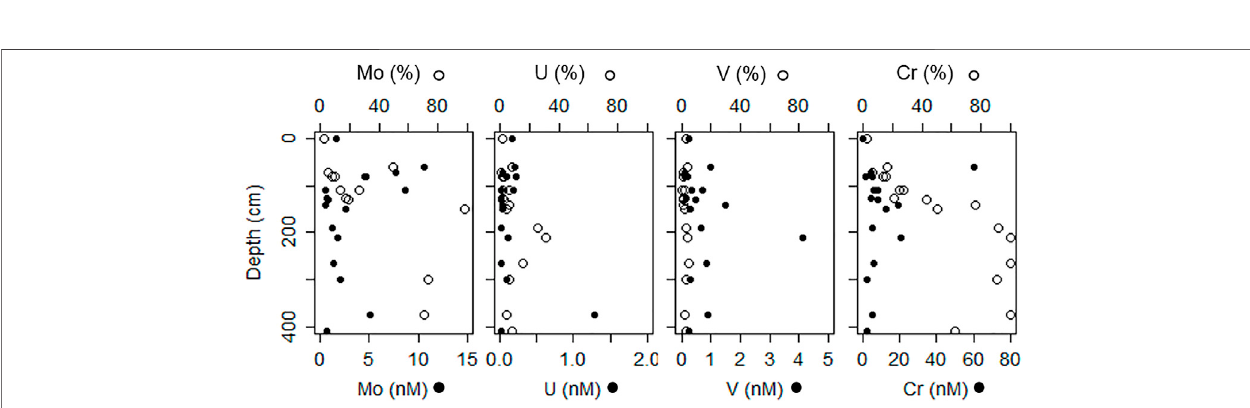
( Figure 5B ). Non-conservative removal occurred at all depths in summer 2013; at 90 cm and deeper in summer 2014; and at 140 cm and deeper in both winters. The anomalies calculated from three-endmember mixing typically fell between those calculated from mixing between the surface water and either the shallow or deep freshwater endmember.